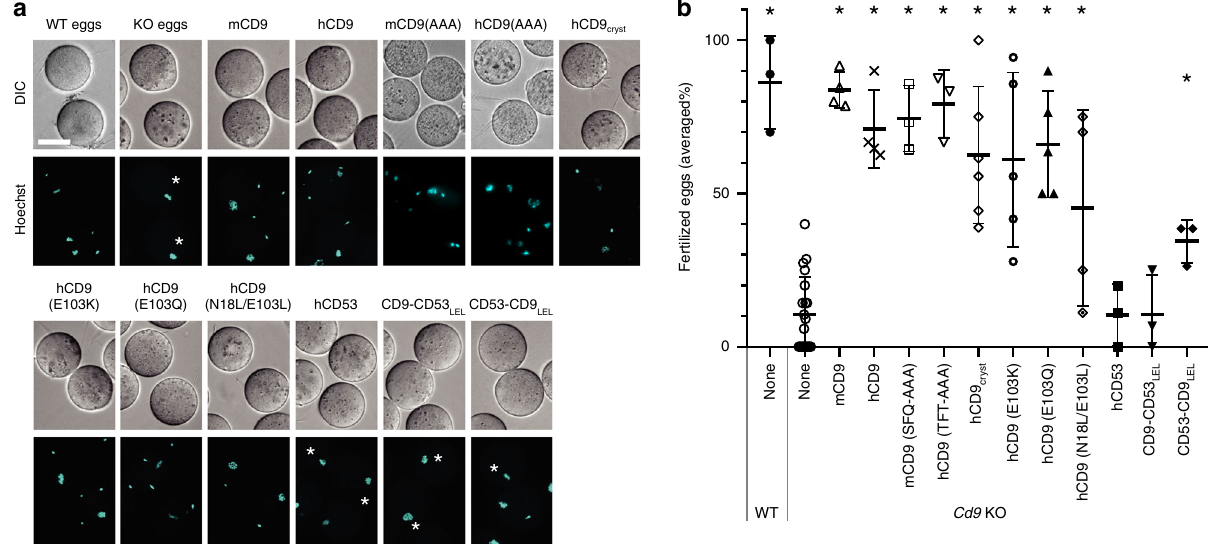
Fig. 5 Sperm – egg fusion complementation assay. a Functional complementation of Cd9 KO mouse eggs by mRNA injection. The mRNA, encoding the WT or mutants of mouse CD9, human CD9, or chimeric constructs between human CD9 and CD53, was injected into the mouse Cd9 KO eggs. The fusion of mouse spermatozoa was visualized by the transfer of DNA dye from the eggs to the sperm nuclei. Asterisks indicate unfertilized eggs. Scale bar, 50 µ m. b Fertilization rates in the sperm – egg fusion assay. The averaged fertilization rates of repetitive experiments are shown with error bar of standard deviation. Each dot represents one experiment. Asterisks indicate signi fi cant differences from the Cd9 KO eggs (two-tailed, unpaired Student ’ s t -test, * P < 0.005). The number of experiments and eggs are indicated in Supplementary Fig. 8c and also provided as a Source Data fi